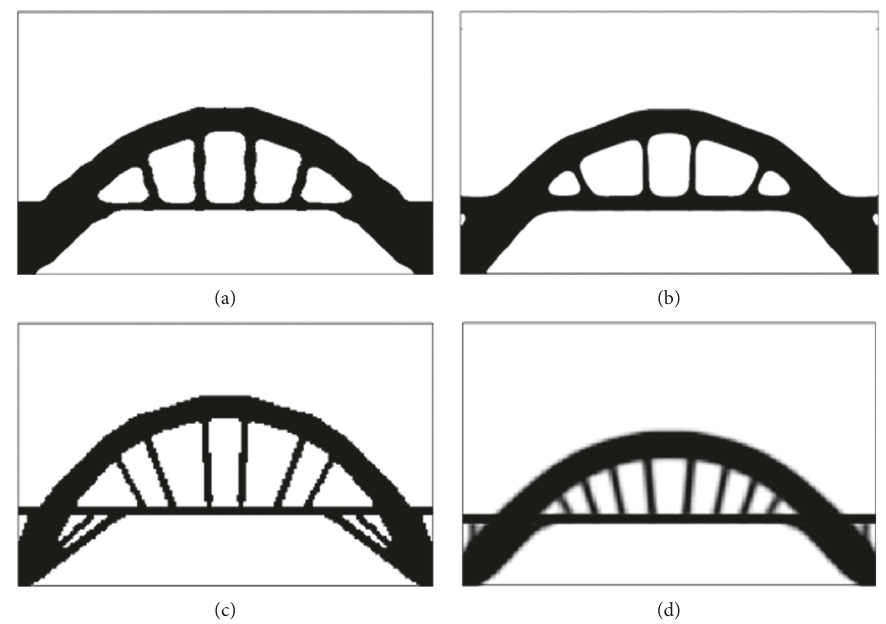
Figure 7: The optimal layout of half-through arch bridge by different methods: (a) PLSM, (b) CLSM, (c) BESO, and (d) SIMP.